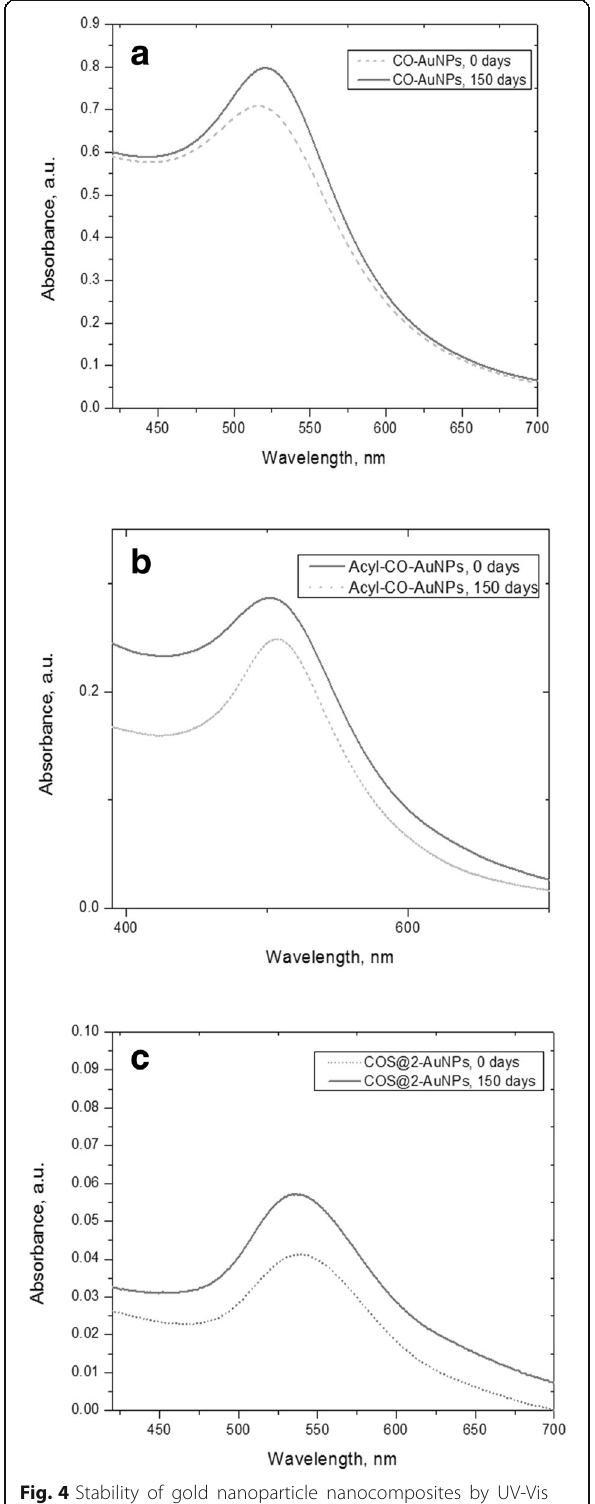
Fig. 4 Stability of gold nanoparticle nanocomposites by UV-Vis absorption spectra obtained 150 days after synthesis: chemically synthesized CO-AuNPs ( a ) and Acyl-CO-AuNPs ( b ) and green/ one-pot synthesis for COS@2-AuNPs ( c